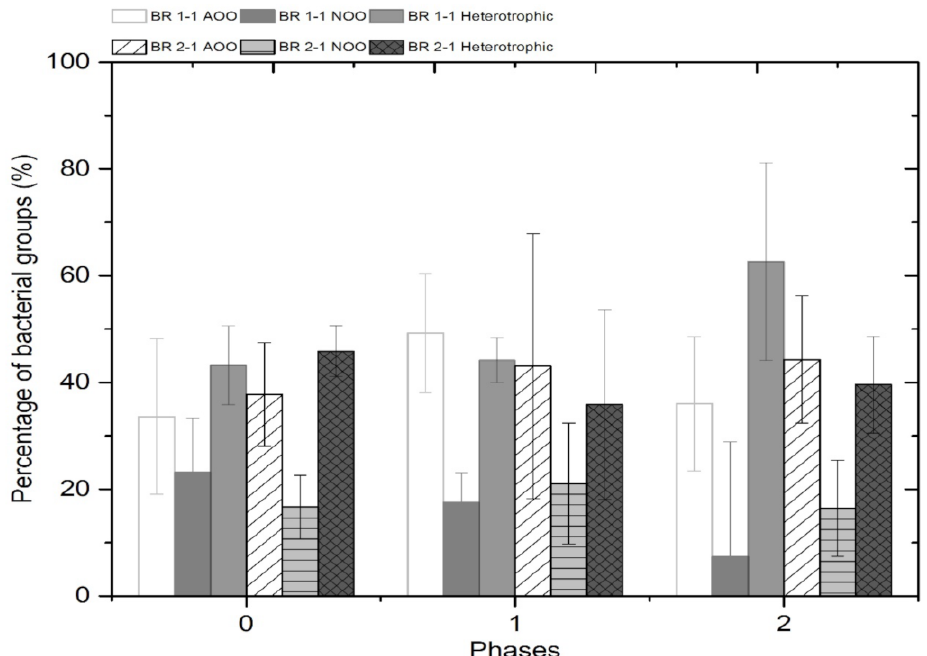
Figure 5. Average shares of bacterial groups in both lanes of the LLTP during the three phases of